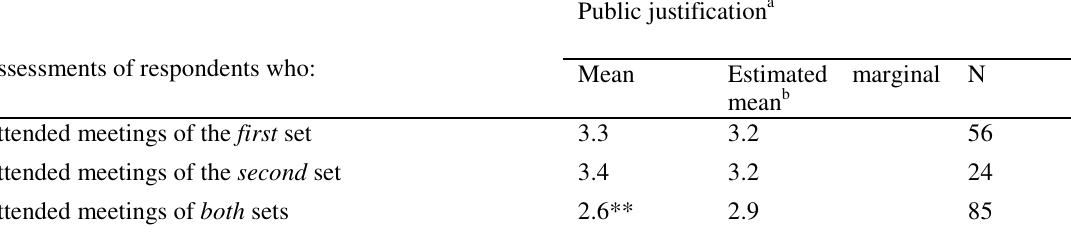
Table 3. Assessments of public justification by meeting attended (raw mean scores and estimated marginal means controlling for